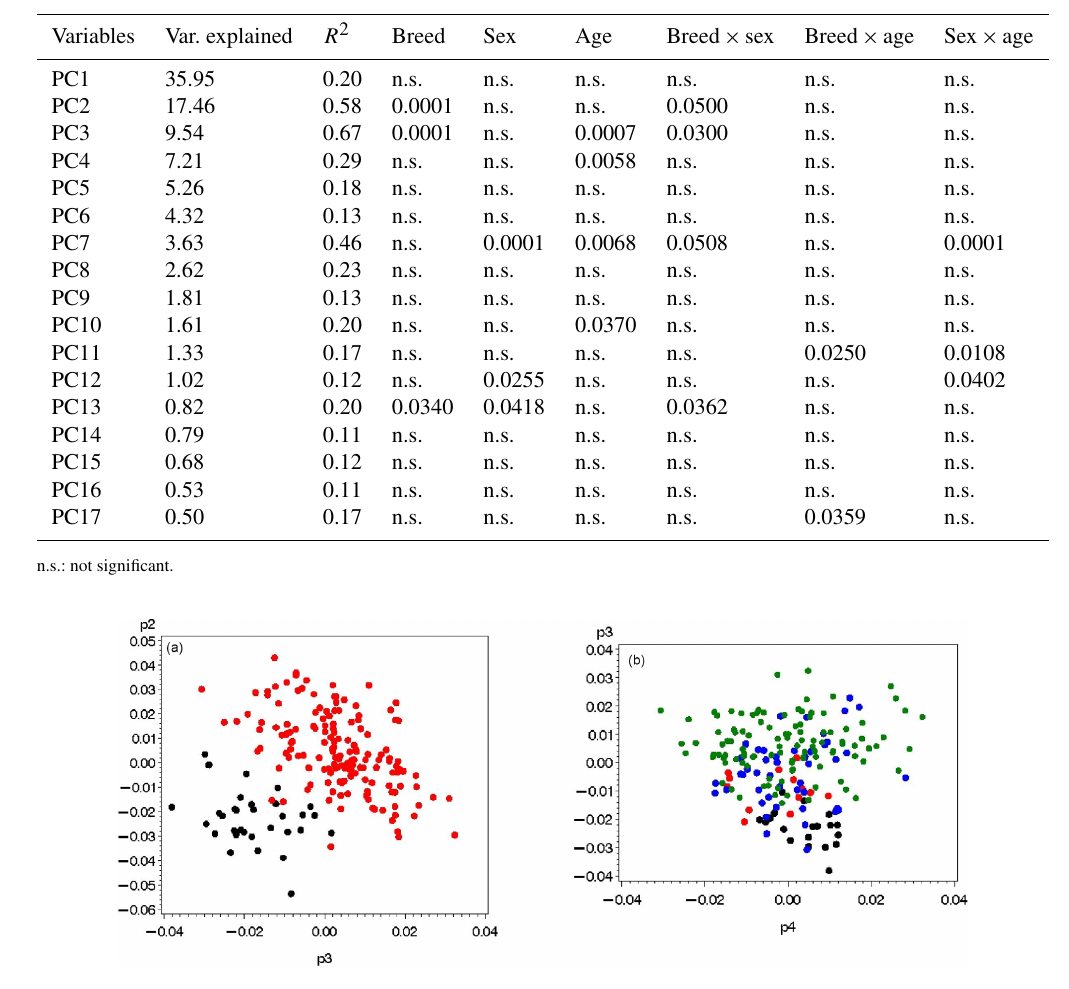
Figure 3. Scatter plot of shape variables and plot of PC2 and PC3 containing 158 Lipizzan and 32 Shagya Arabian horses (a) (red: Shagya Arabian; black: Lipizzan). (b) The scatter plot for PC3 and PC4 of the same sample (black: Shagya Arabian younger than 6 years; red: Shagya Arabian older than 6 years; blue: Lipizzan younger than 6 years; green: Lipizzan older than 6 years) is